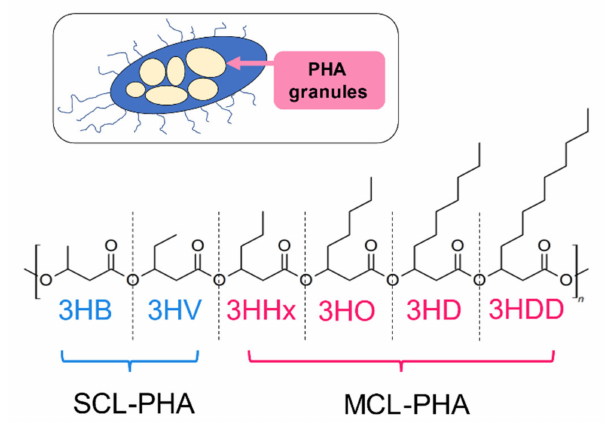
Figure 1. Polyhydroxyalkanoates with short chain-length repeat units (Scl-PHA) monomers include 3-hydroxybutyrate (3HB) and 3-hydroxyvalerate (3HV). Mcl-PHA monomers include 3-hydroxyhexanoate (3HHx), 3-hydroxyoctanoate (3HO), 3-hydroxydecanoate (3HD), and 3- hydroxydodecanoate (3-HDD). PHA granules accumulate within the cytoplasm of the bacteria cell. Principal microbial producers of mcl-PHAs include Pseudomonas sp.